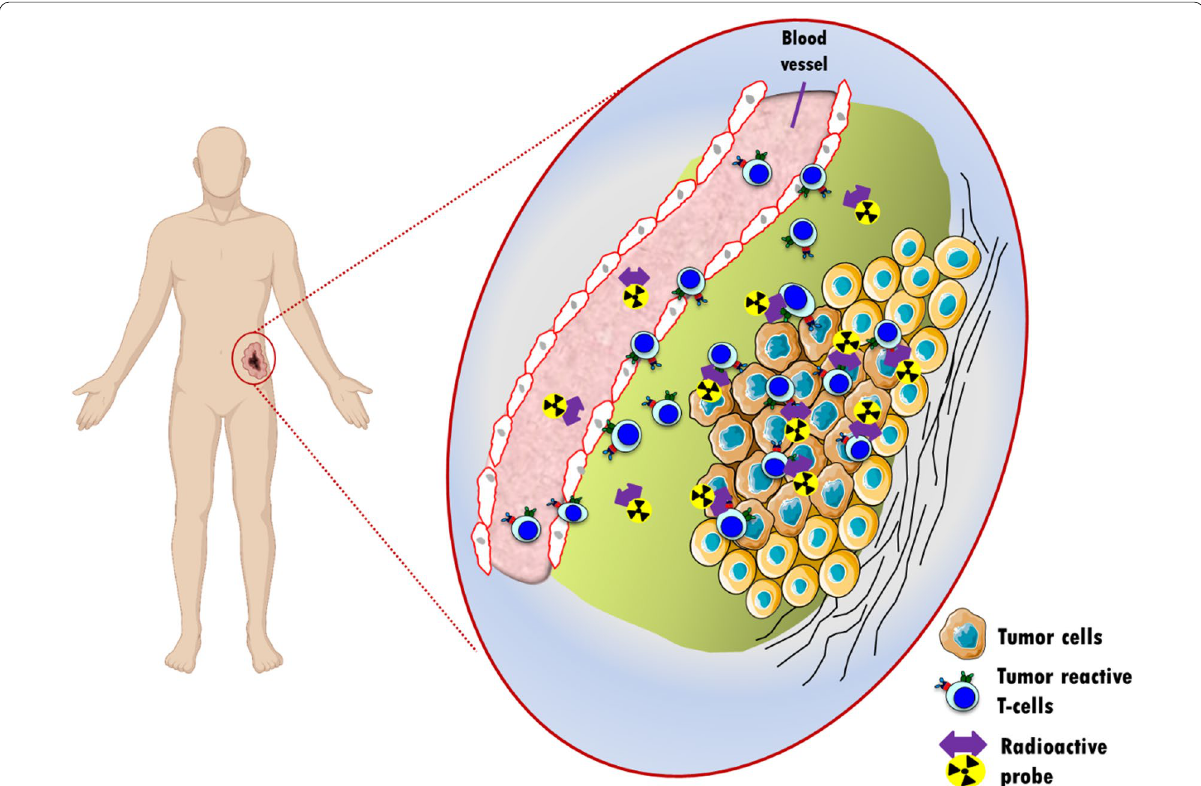
Fig. 1 Principle of non-invasive in vivo imaging of lymphocytes trafficking to and into the tumor. Activated tumor-reactive T-cells are intravenously injected into a patient having a tumor specifically recognized by those T-cells. The accumulation of the T-cells within the tumor is visualized in-situ using radiolabelled probes recognizing specific markers expressed on the T-cell membrane. The radioactive probe targeting T-cells can be either a full-size antibody and its derivatives, or a short peptide radiolabelled with a radioisotope (PET or SPECT isotope) matching the plasma half-life of the probe